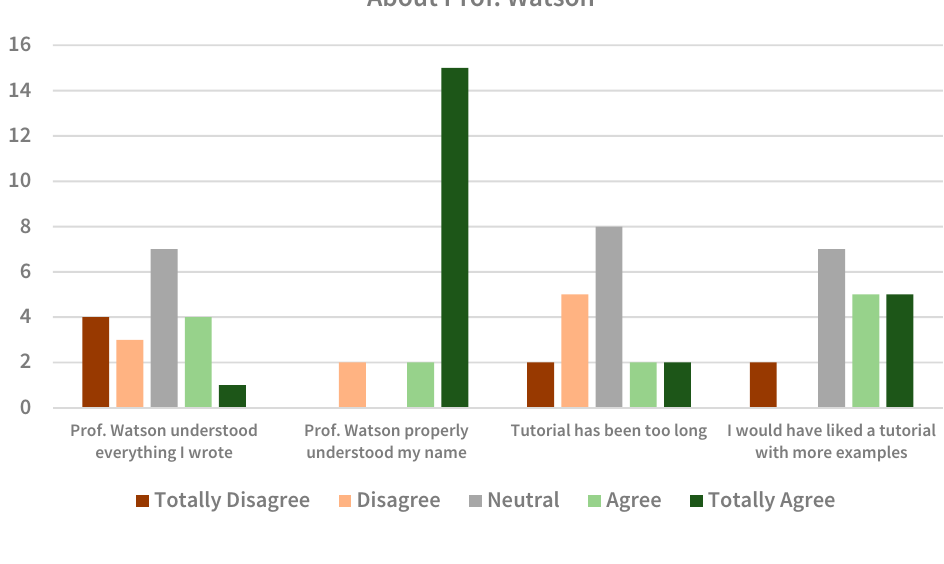
Figure 4. Prof. Watson grading